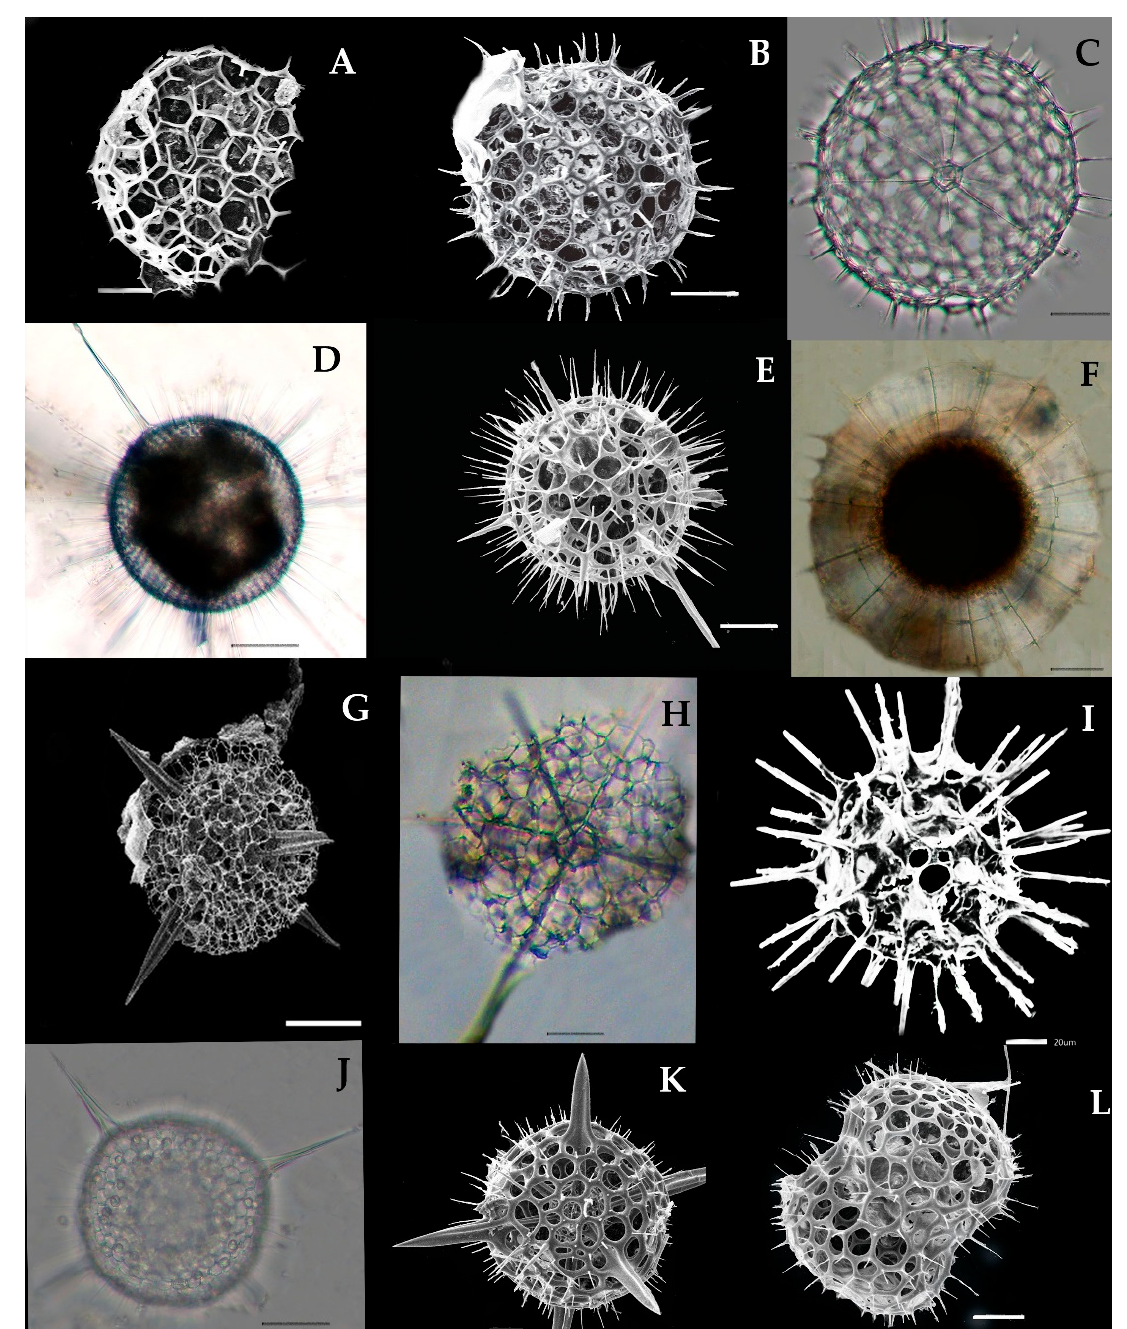
Figure 6. Light and scanning electron micrographs of Spumellarian species ( A – L ). The images were modified from Munir et al. [27]. ( A ) Acanthosphaera actinota ; ( B ) Acanthosphaera pinchuda ; ( C , D ) Actinosphaera capillacea, ( E ) Actinosphaera tenella , ( F ) Arachnosphaera myriacantha , ( G ) Cromyechinus circumtextum , ( H ) Centrocubus cladostylus, ( I ) Elatomma penicillus, ( J , K ) Hexalonche amphisiphon, ( L ) Didymocyrtis tetrathalamus. Scale bars: 10 µm, 20 µm, 100 µm.